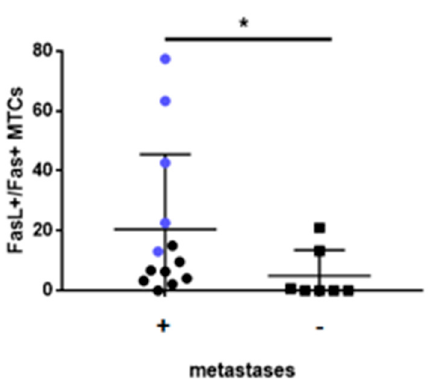
Figure 5. Significant di ff erences between FasL +/ Fas + MTCs in LNs aspirates in patients with confirmed metastases in LNs and patients without confirmed metastases in LNs, * p = 0.0439. Data are expressed as median with interquartile range. * Di ff erences between groups are significant in Mann–Whitney U-test. Blue dots represent patients with IV stage of the disease.